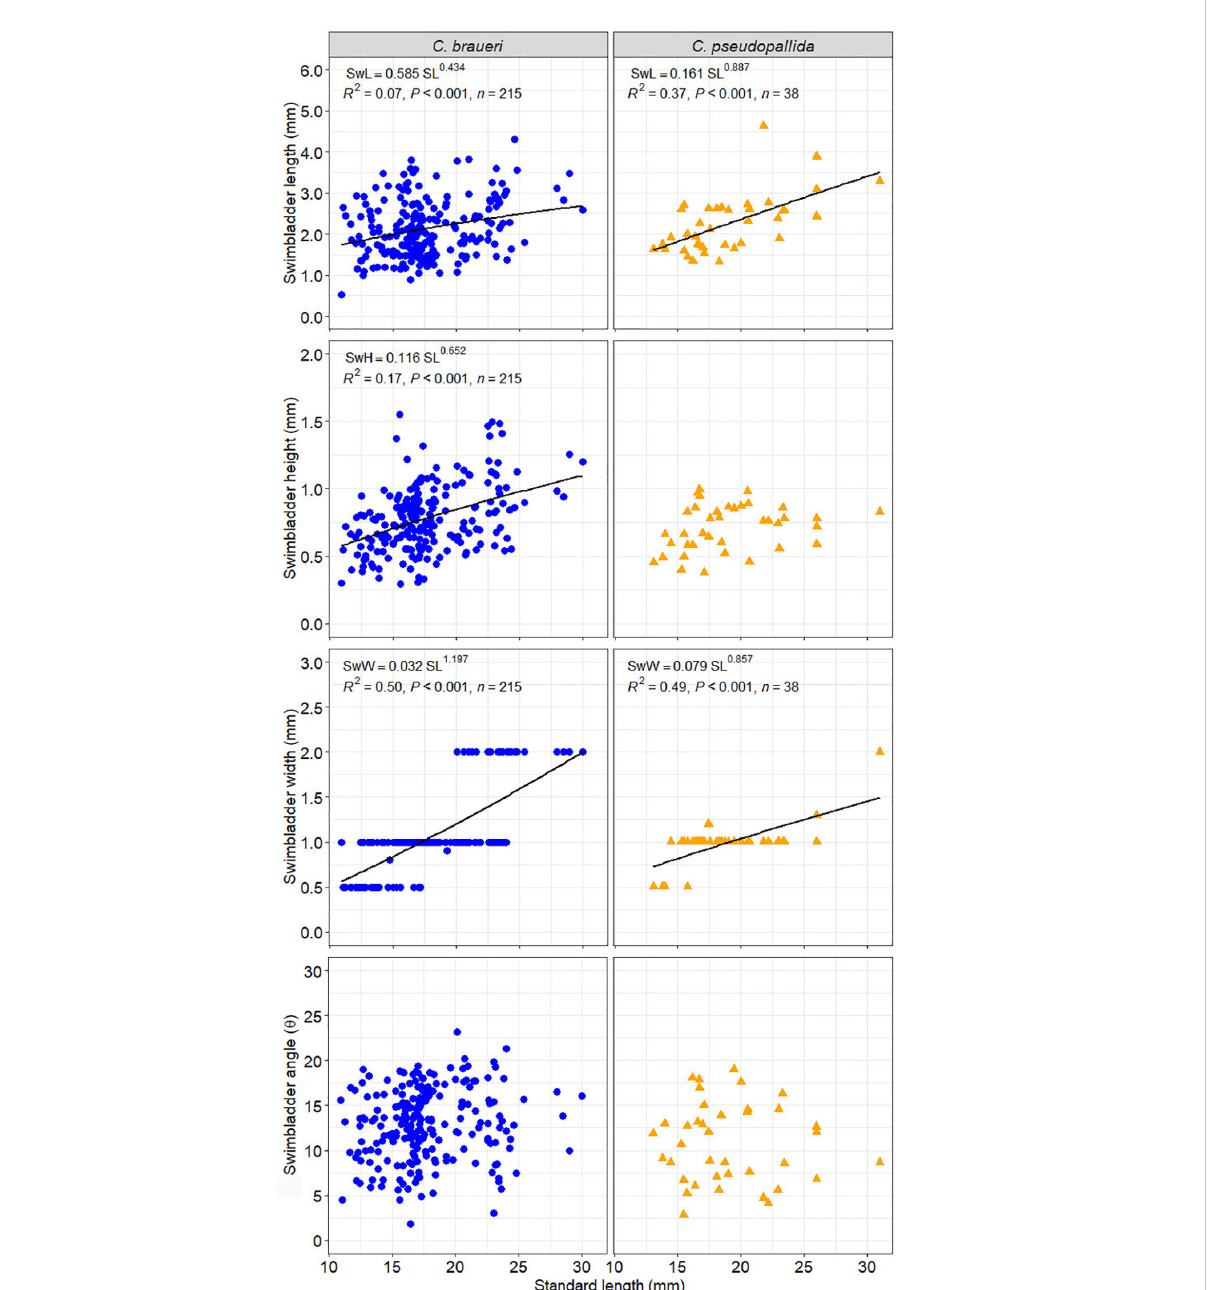
FIGURE 10 Relationship between standard length and swimbladder length (SwL), height (SwH), width (SwW), and angle (Sw q ) for C. braueri (blue dots) and C. pseudopallida (yellow